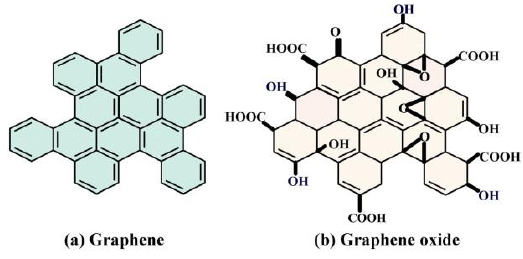
Fig. 9. Chemical structure of graphene and graphene oxide